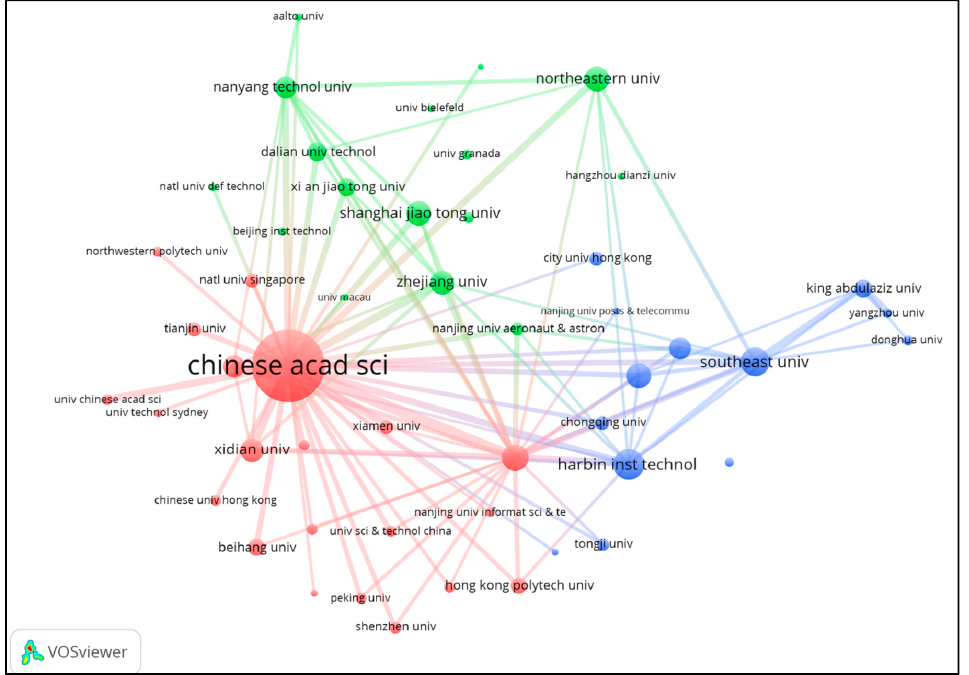
Figure 9. Bibliographic coupling of the institutions publishing in NC.